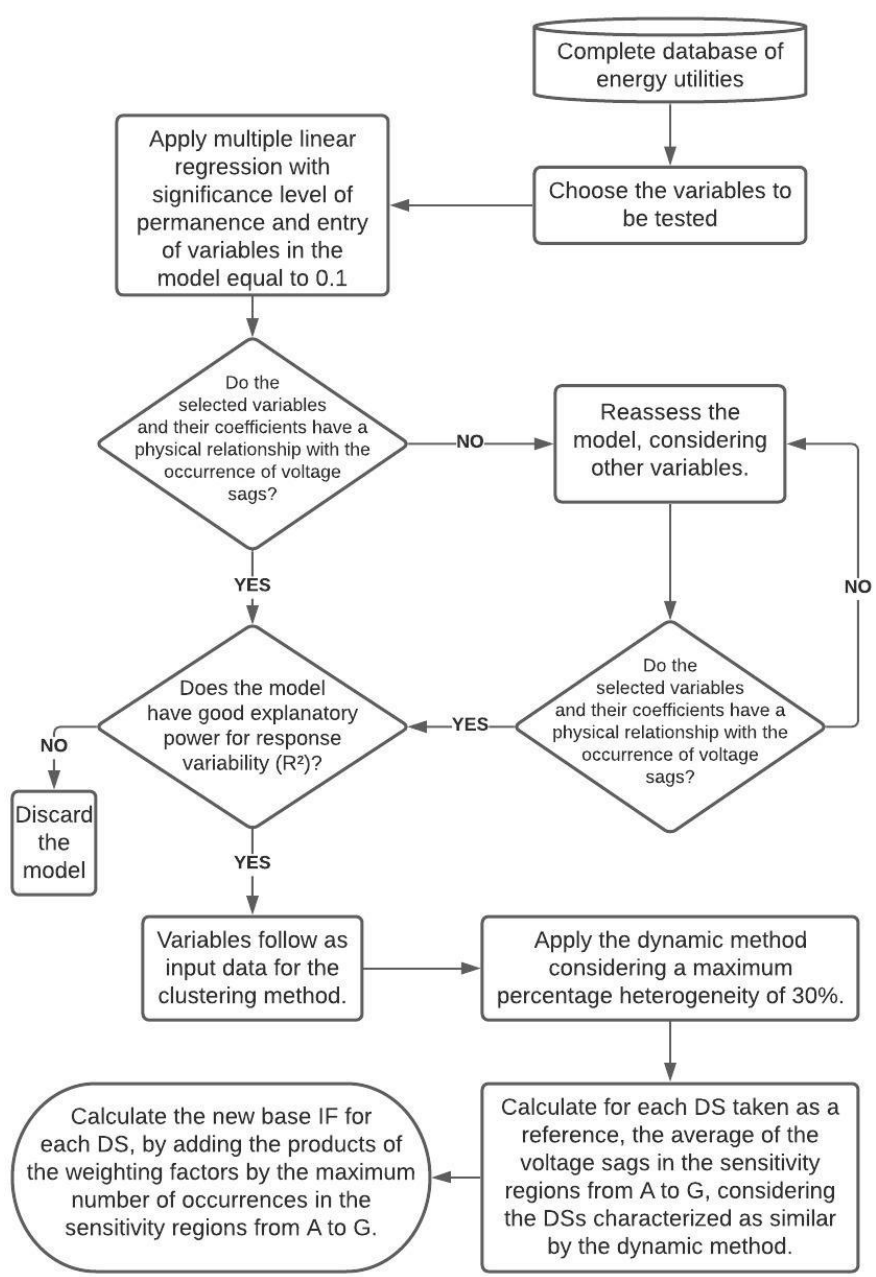
Figure 2. Flowchart of the proposed methodology.